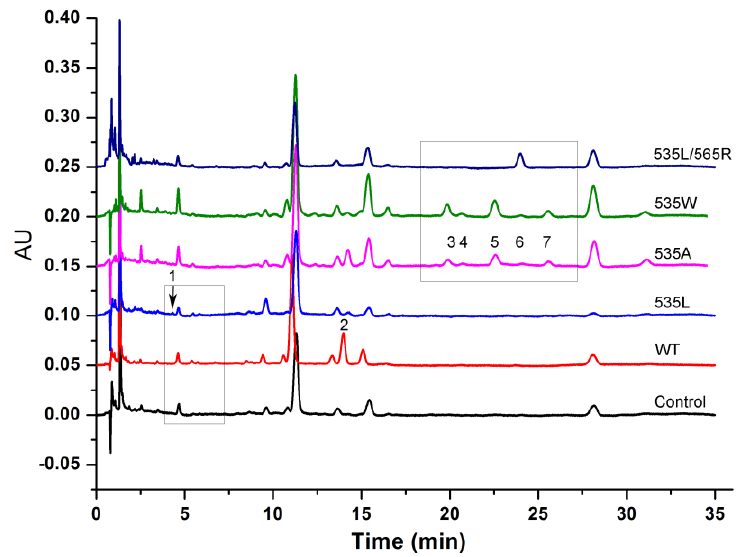
Figure 5. Extracted ion chromatogram of the 535 site and Y535L/C565R double mutant activity.